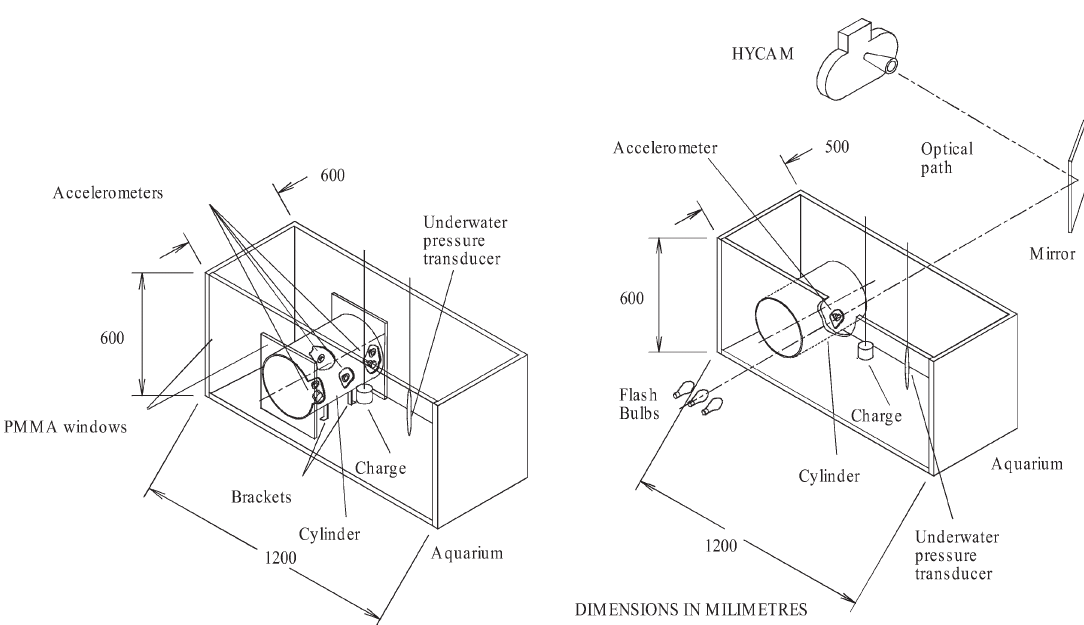
Fig. 1. Schematic of the aquarium and cylinder experimental set-ups for events 1–4, left, and 5–7, right. Shown are the charge, pressure transducer and cutouts of the cylinder to indicate the accelerometer locations.